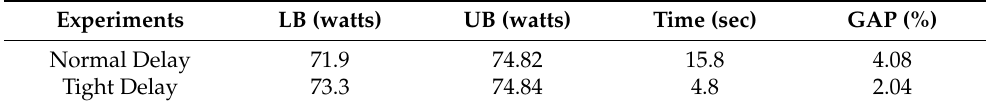
Figure 6. ( a ) Result when the delay constraint is set to 249.37585529 in many-to-one WSN transmis- sion; and ( b ) result when the delay constraint is set to 113.1925051 in many-to-one WSN transmission. Table 3. LR Results of a Many-to-one WSN Transmission Experiment.